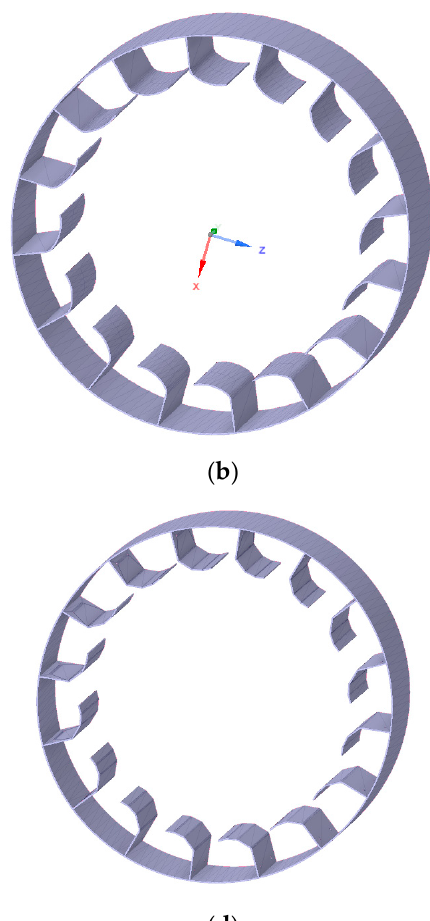
Figure 2. The geometrical models proposed for the analysis: ( a ) L-type flights, ( b ) hook-type flights, ( c ) cup-type flights, ( d ) rectangular double-angled type flights — the real case.